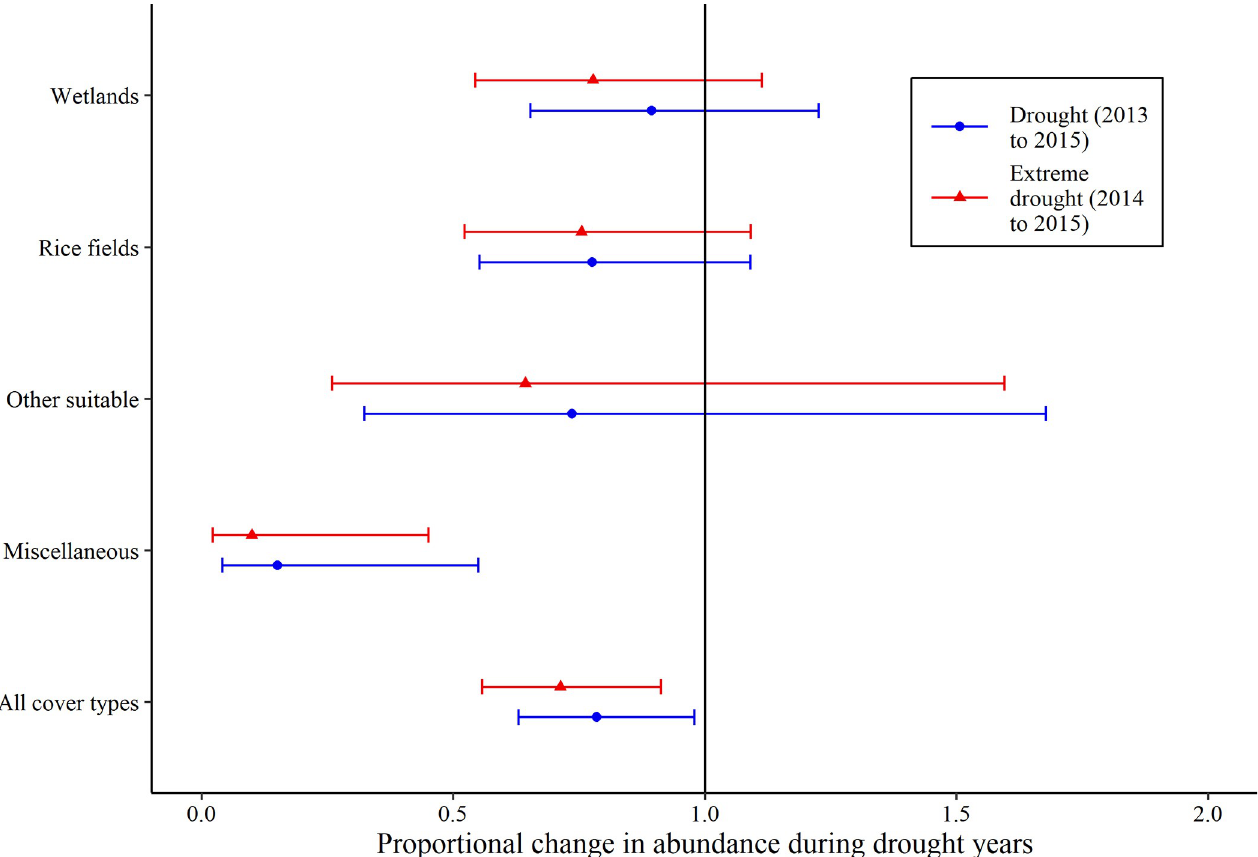
Fig 2. Estimated abundance of total shorebirds during a drought year among four dominant cover types. Results from generalized linear mixed models of the annual abundance of total shorebirds from 2011 to 2016 in the Central Valley, California, USA. Plots for each land cover type show the estimated proportional change in total shorebird abundance relative to a non-drought year from two models; drought models classified drought years as a period of a 3-year drought (2013–2015) or 2-year extreme drought (2014–2015). The solid black line represents no change from the estimated abundance of total shorebirds during a non-drought year. See Methods for details on the types of land cover that composed the “other suitable” and “miscellaneous” land cover categories.